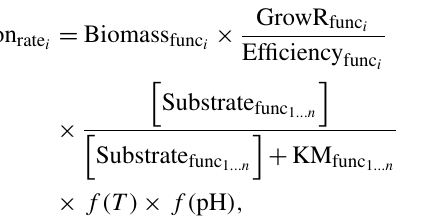
(white on Fig. 3). Total precipitation during the drought pe- riod was 700 mm in 2015 and 1088 mm during the same time frame in 2016 (Zimmerman,